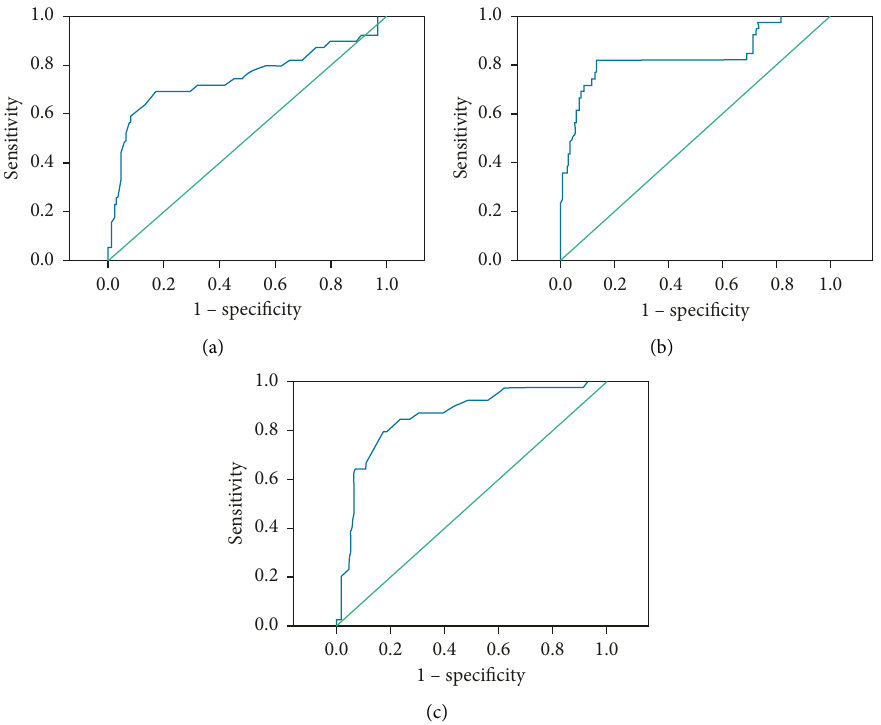
Figure 3: (a–c) ROC analysis for RDW, BNP, and PA :A predicting PH in COPD. (a) ROC curve with the RDW at identifying PH. The AUC was 0.749 0.054 ( p ± <